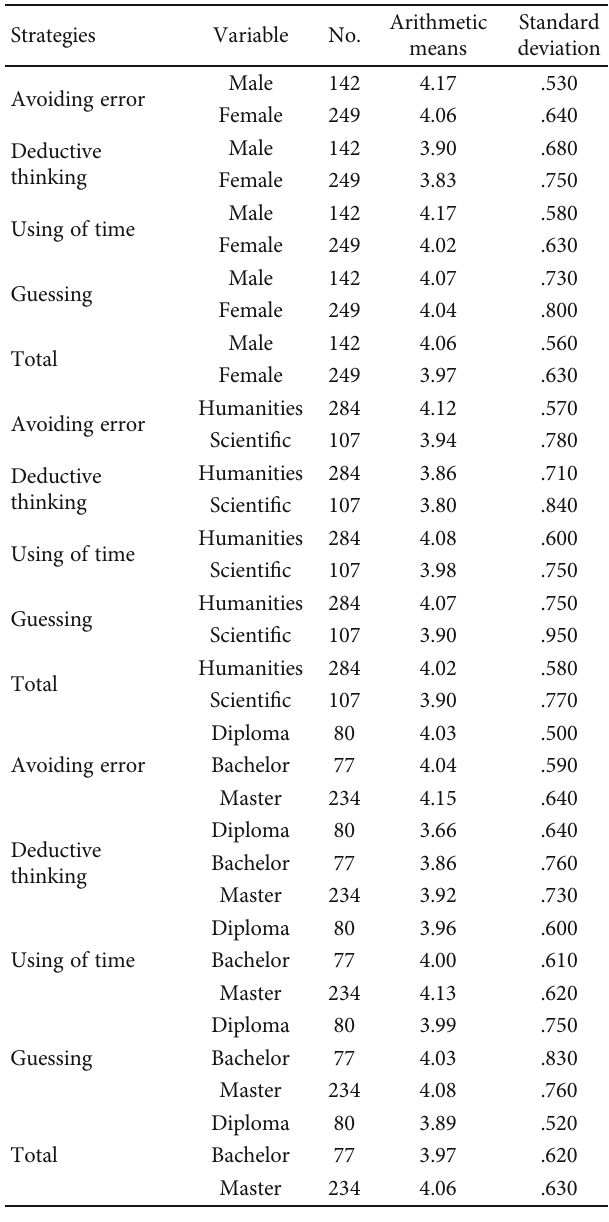
Table 4: Arithmetic means and standard deviations of the degree to which Amman Arab University students possess test wiseness strategies.